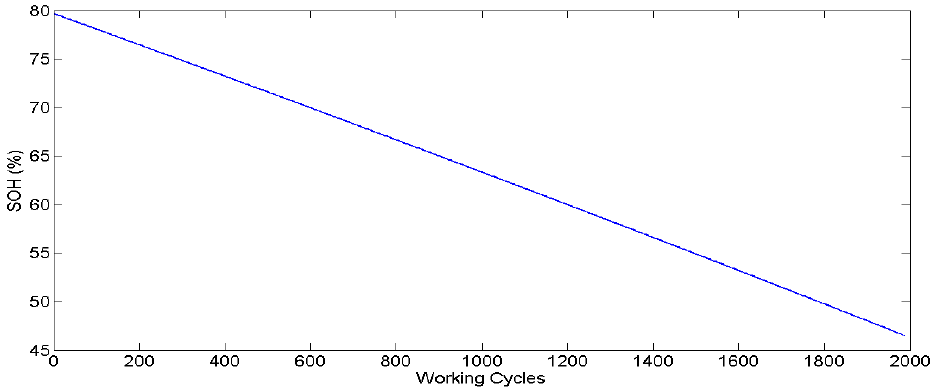
Figure 3. Aging evolution of second ‐ life electric vehicle (EV) batteries under the 1 min time lag.